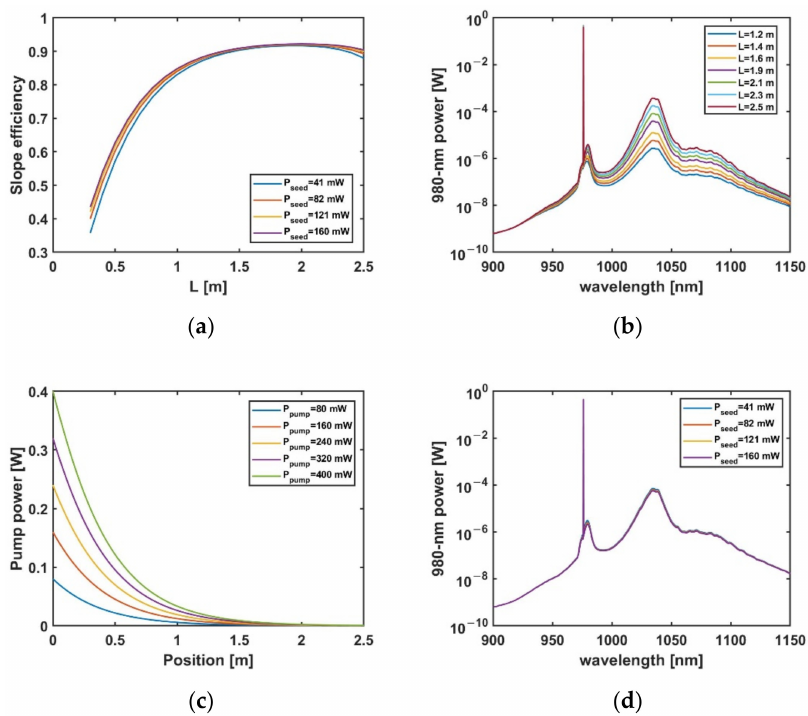
Figure 1. ( a ) The variations of slope efficiency with active fiber length. ( b ) The variation of output spectrum with active fiber length. The pump and seed power are 400 mW and 160 mW, respectively. ( c ) The variations of pump power along the active fiber. ( d ) The variation of spectrum with seed power. The active fiber length and pump power are 2.0 m and 160 mW,